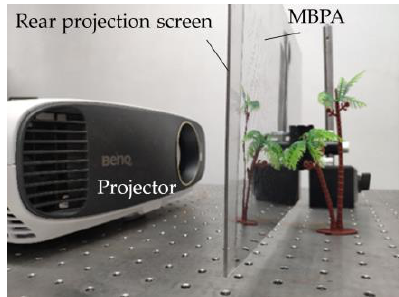
Figure 3. The experimental system of the proposed reflective AR display.